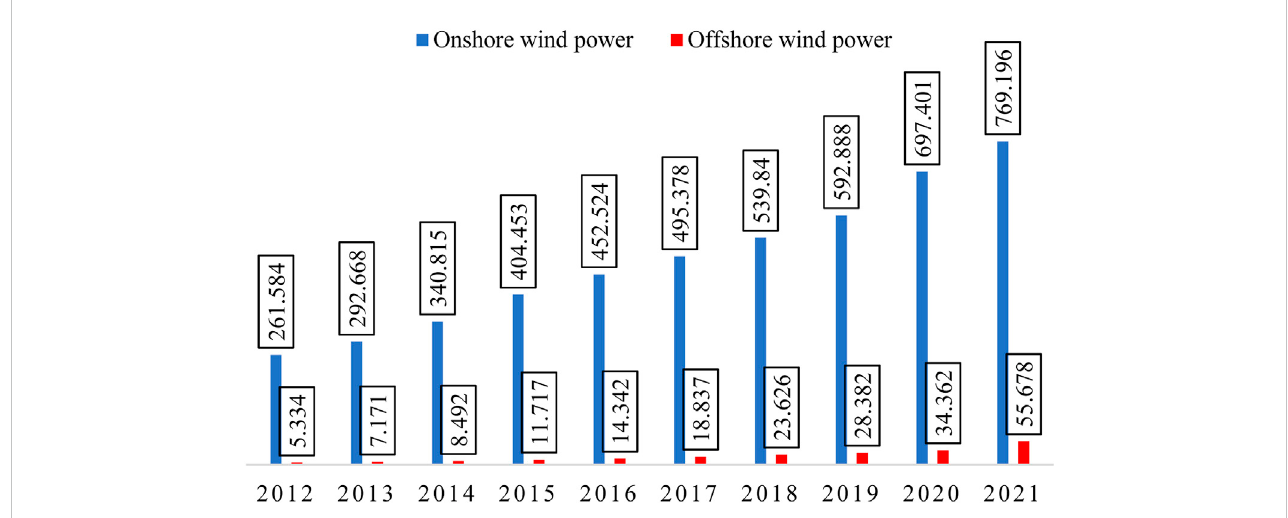
FIGURE 1 Global onshore and offshore wind power installation trends (in GW) from 2012 to 2021 (I. Renewable Energy Agency, 2022).